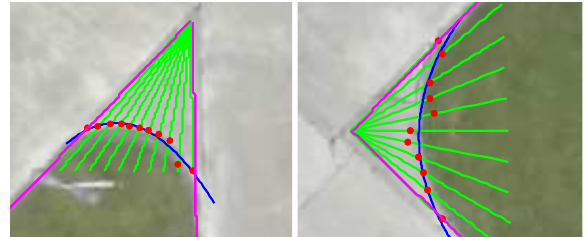
Figure 4: Refinement of the road edges at the round corners. In this figure, the magenta lines are the extracted straight road edges, the green lines are the search lines, the red points are the search results for the round corner edges, and the blue line is the curve fitted to the points determining the road’s round corner edge.